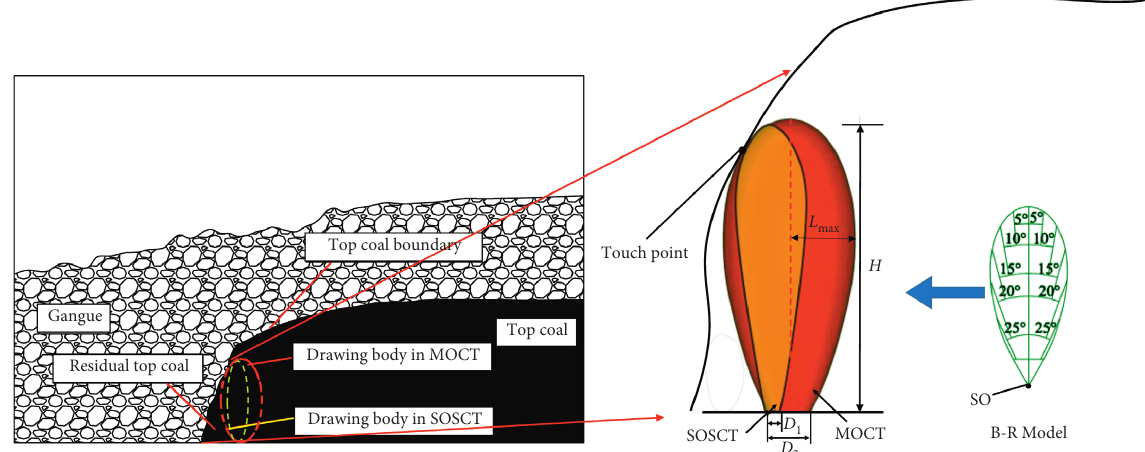
Figure 2: Comparison of different drawing